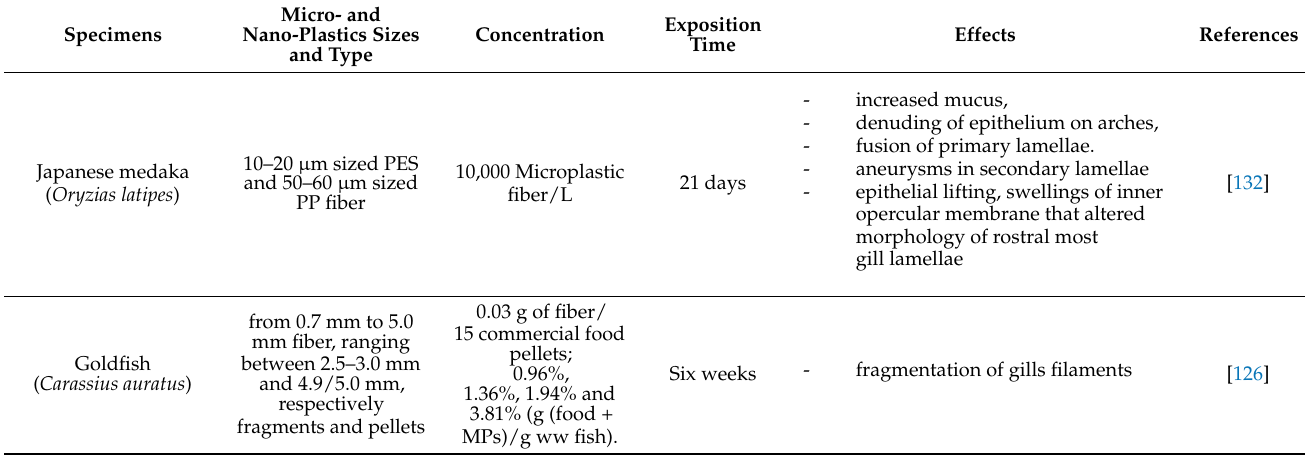
Table 2. Effects of micro and nano plastics on